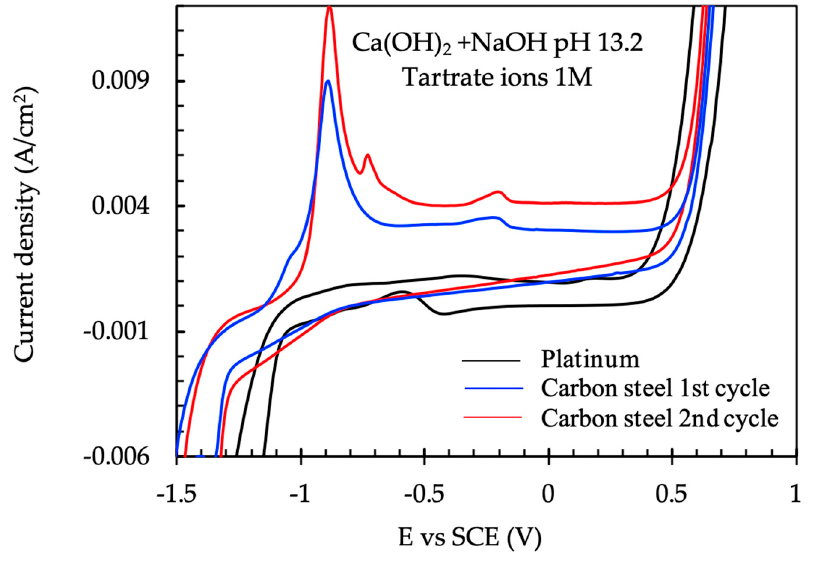
Figure 13. Cyclic voltammetry curves of carbon steel and platinum in saturated Ca(OH) 2 solution + NaOH at pH 13.2 and tartrate ions 1